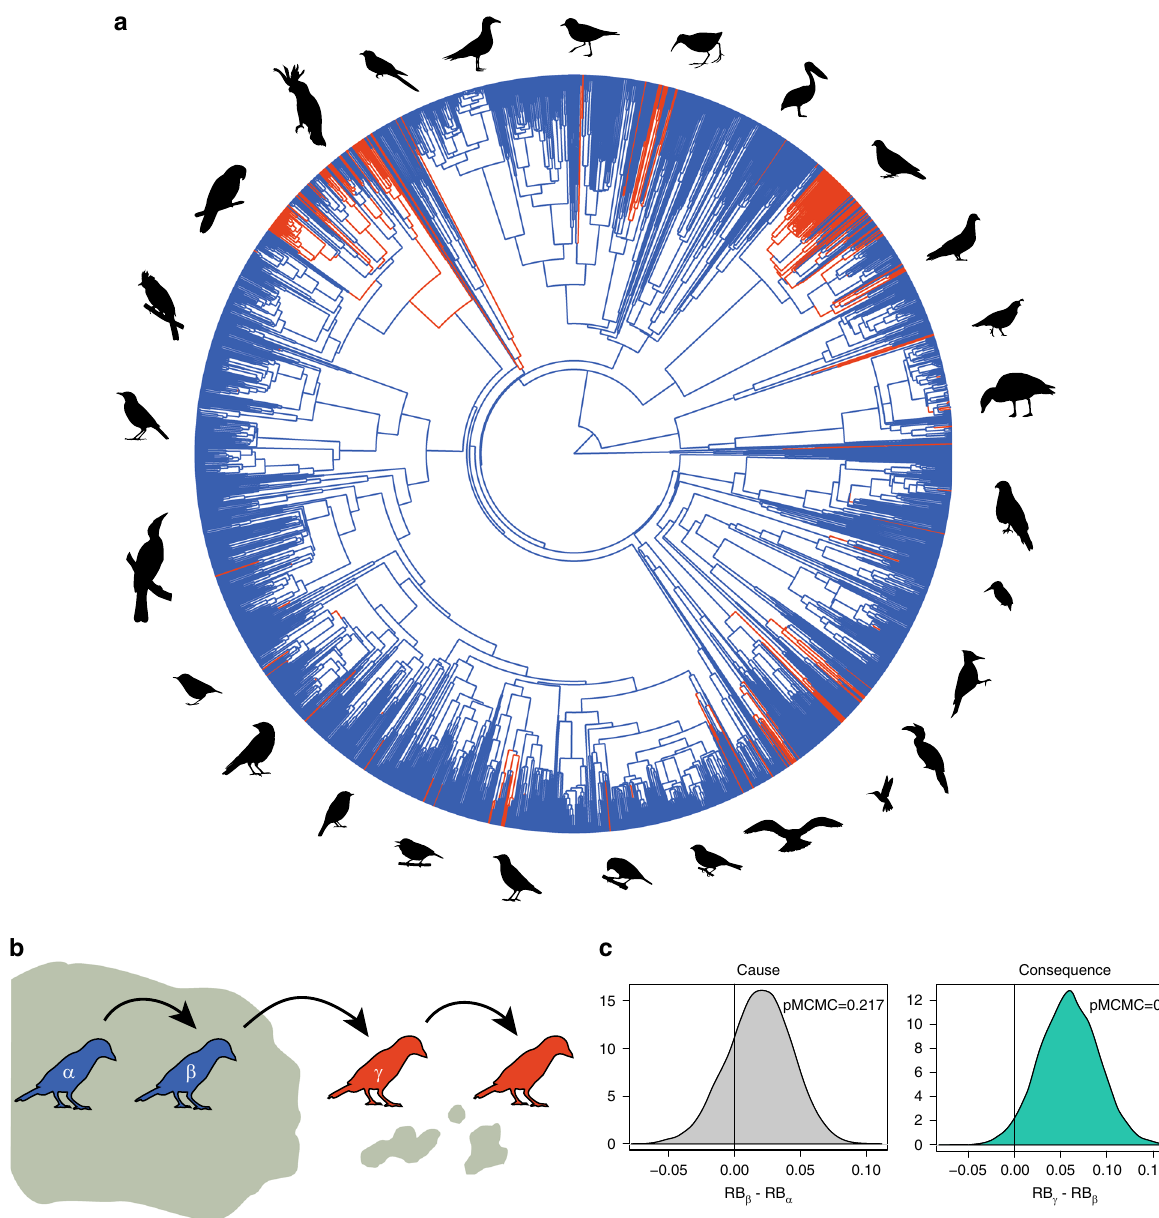
Fig. 2 Reconstructions of island colonizations and relative brain size changes. a The phylogenetic distribution of oceanic island-living birds (110 species coloured in red)*. Internal branches show estimated transitions from island to mainland and vice versa in one of the ancestral estimations, where red and blue branches represent island and mainland living, respectively. b Representation of ancestors and descendants in the different types of transitions studied: continent to continent ( α ), continent to islands ( β ), and islands to islands ( γ ). c Histograms show the difference in relative brain size (RB) between different ancestral types, comparing the posterior samples of each category from the BPMM. Bird silhouettes were drawn by FS and are available at PhyloPic